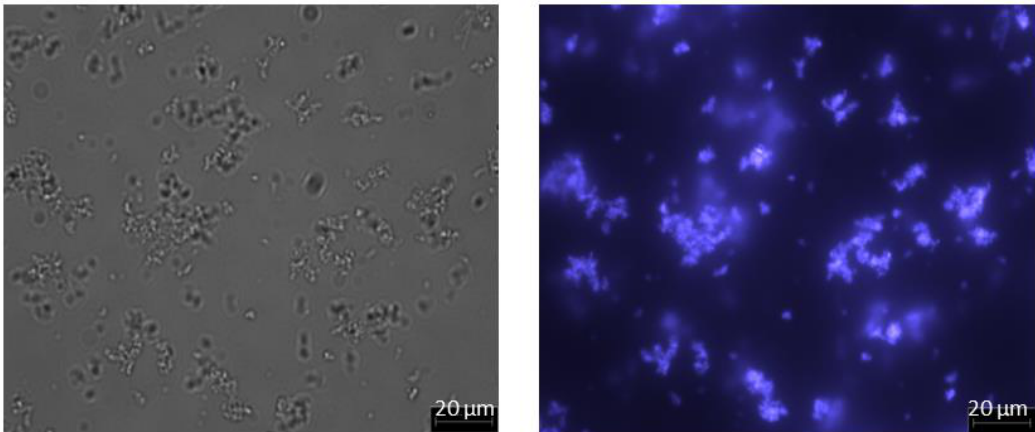
Figure 4. Micrographs of PEGylated FITC-BSA solution adjusted to 1.65 M ammonium sulfate concentration (left: image obtained by optical microscopy; right: image of same field obtained by fluorescence microscopy; magnification: 50×).